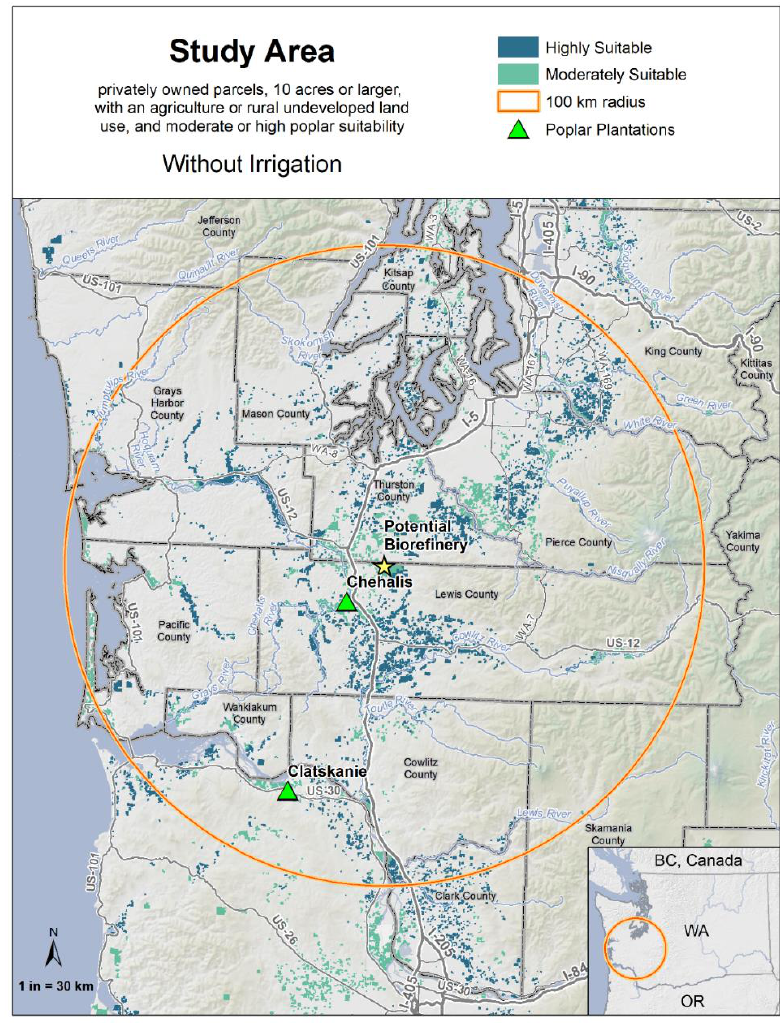
Figure 2. Parcels suitable for poplar growth without the use of irrigation within 100 km of a potential biorefinery in Centralia, WA, USA [24]. (Note: The techno-economic assessment used 100 km road distance between parcels and the potential refinery. We used a 100 km radius straight-line distance, making our study region larger.) Suitability is based on soil type, topography, and other geophysical site characteristics. Most parcels labelled as moderately suitable become highly suitable with